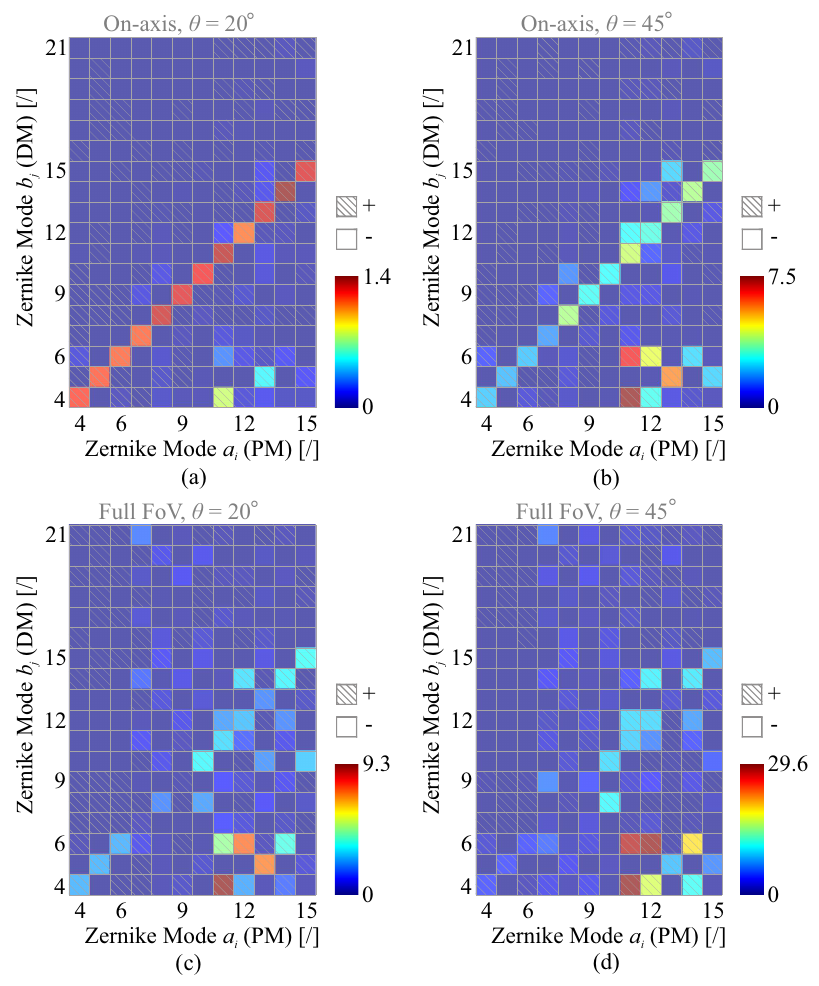
Figure 12. Elements in the matrix T in an absolute value, where the mapping orders for a i and b j are i = 4 − 15 and j = 4 − 21, respectively. Four configurations are plotted: ( a ) on-axis, θ = 20 ◦ ; ( b ) on-axis, θ = 45 ◦ ; ( c ) full FoV, θ = 20 ◦ ; ( d ) full FoV, θ = 45 ◦